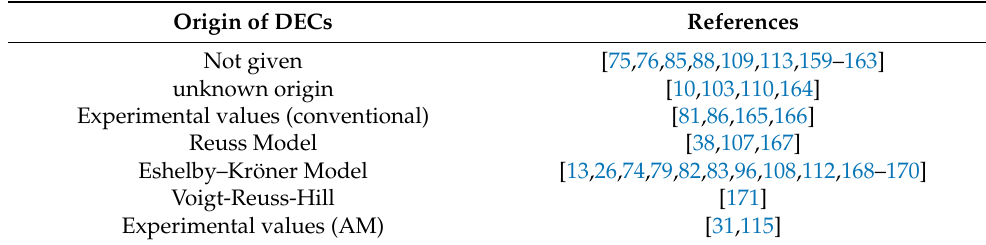
Table 4. Origins of applied diffraction elastic constants used for stress calculation in additively manufactured